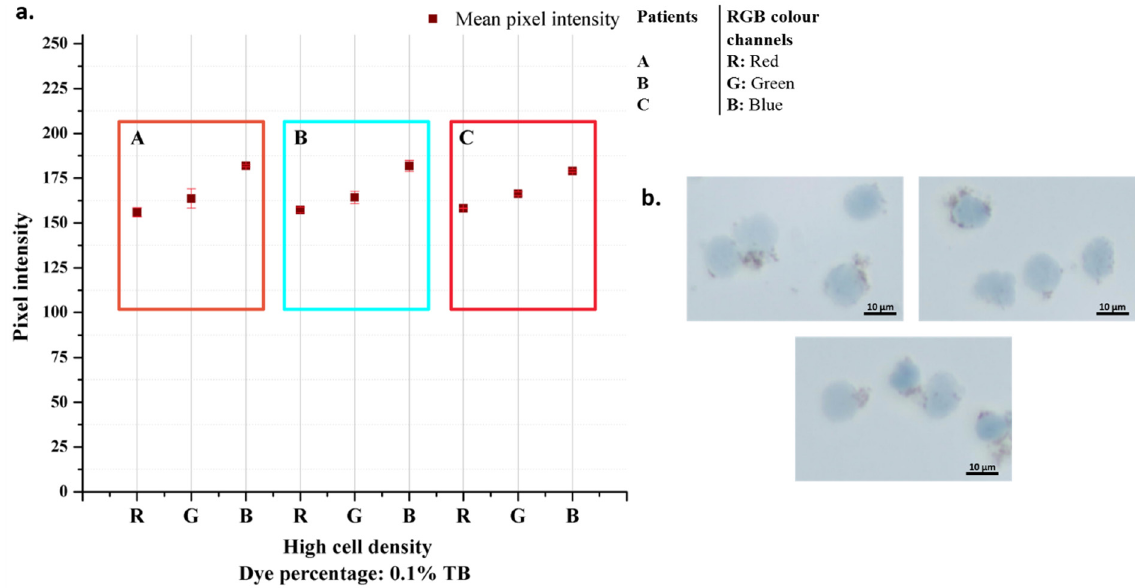
Figure 9. Patient samples analysis results ( a ) and their microscopic images taken with 50× objective ( b ).